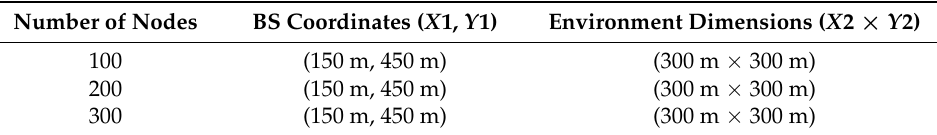
Table 3. The essential simulation parameters of the second